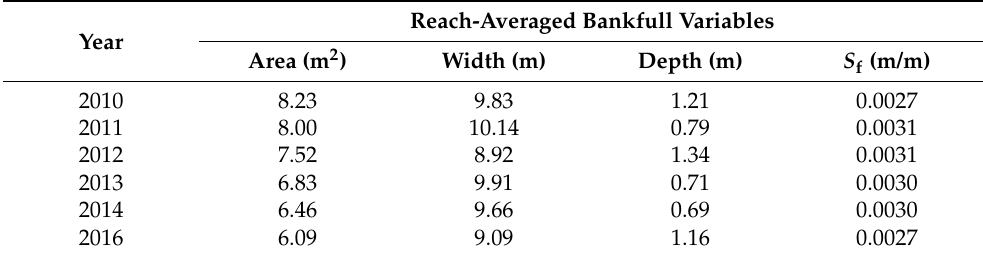
Table 8. Reach-averaged cross-sectional area, channel width, flow depth, and friction slope ( S f ) at bankfull conditions obtained from post-restoration monitoring reports